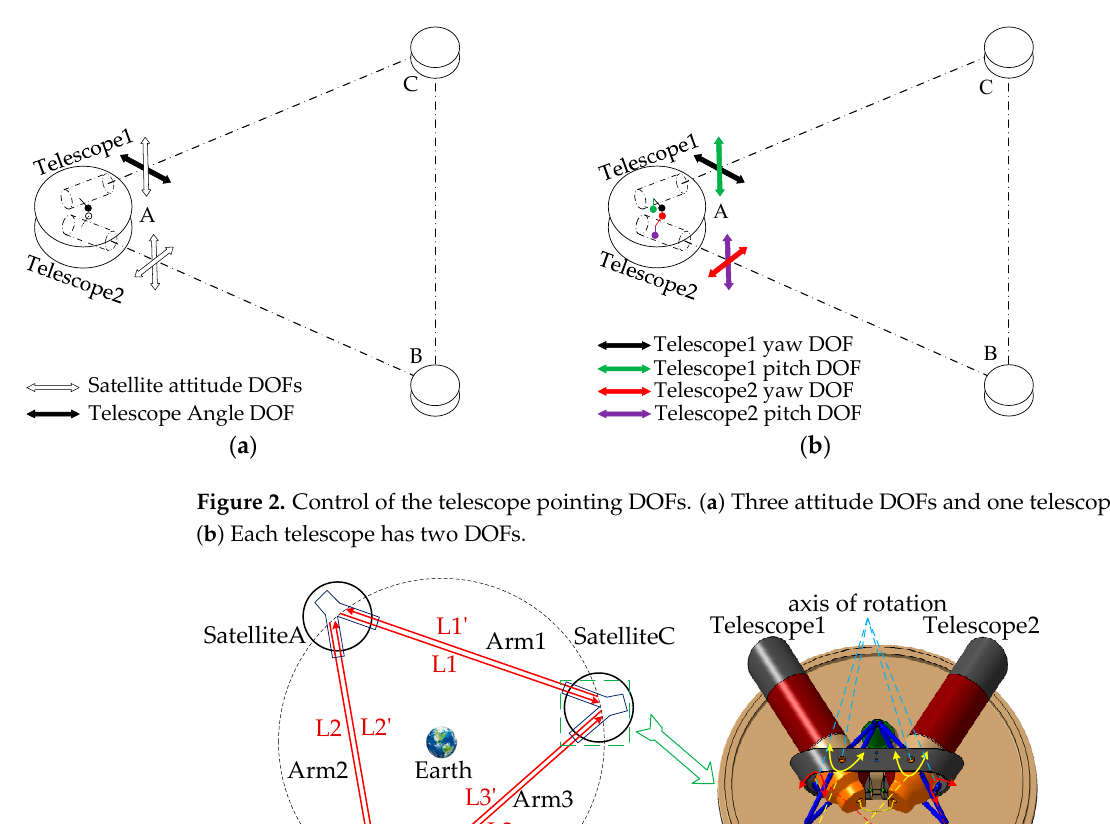
Figure 3. Configuration of the satellite platform for the GWs detection mission.